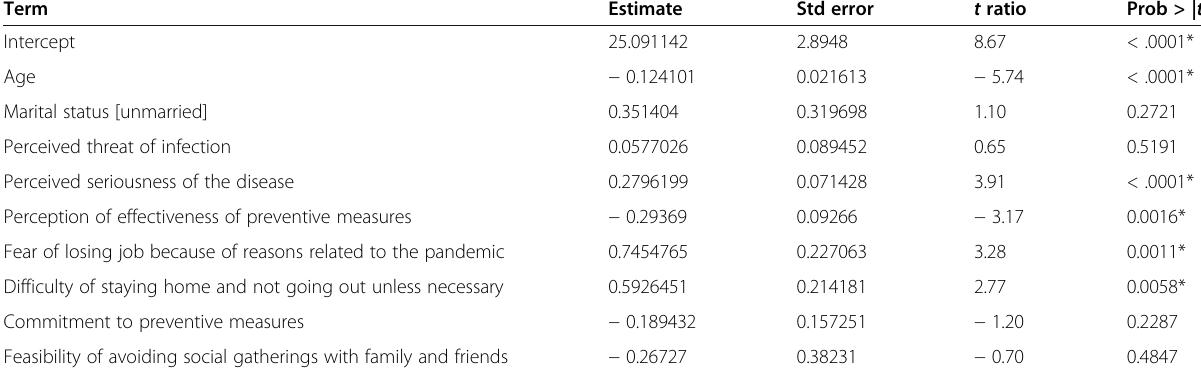
Table 4 Multiple linear regression predicting psychological distress among the studied sample